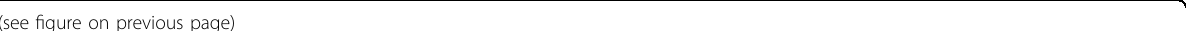
Fig. 1 WT and variant-speci fi c LNP-mRNA elicited potent antibody response against Omicron BA.1 and BA.2. Schematics ( a ) and spike structure ( b ) showing Omicron BA.1 and BA.2 mutations distribution in the vaccine design (a) and one protomer of BA.1 spike trimer (b, PDB: 7T9K). c Comparison of antibody response induced by two doses of 1 µg WT, B.1.351 or B.1.617 LNP-mRNA at 21 days interval. Antibody titers were determined by area under curve (AUC) of ELISA titration curves in Supplementary Fig. S1. d Neutralization of Omicron BA.2 pseudovirus by serum samples from mice vaccinated with 1 µg WT, B.1.351 or B.1.617 LNP-mRNA as illustrated in c . The neutralizing titers were quanti fi ed by log 10 reciprocal IC 50 and calculated from titrations in Supplementary Fig. S2. Gating strategy to select GFP positive infected cells is shown in Supplementary Fig. S5. e BA.1 and WT boosters strengthened waning immunity against Omicron BA.1 and BA.2 variants. ELISA antibody titers of samples from mice sequentially vaccinated with two doses of 1 µg WT LNP-mRNA followed by 10 µg WT (WT × 3, n = 5) or Omicron BA.1 (WT × 2 + BA.1, n = 7) LNP- mRNA boosters. The pre-booster groups (day 35 and > 4 month from prime) to receive WT or BA.1 boosters were denoted as WT × 2 ( + WT) and WT × 2 ( + BA.1) respectively. f Neutralization of Omicron BA.2 pseudovirus by plasma samples from mice in e . g Plaque-reduction neutralization (PRNT50) of Omicron BA.2.12.1 infectious virus by plasma samples from mice in e . Related statistical information and all source data can be found in Supplementary Information or Supplementary Dataset S1. Data points of PBS group showed no statistical difference between collection time points and were combined to one group in e – g . Only comparisons between adjacent time points or groups of same time point were shown in e , f . A subset of collected samples were characterized in pseudovirus and infectious virus neutralization assay due to depletion of